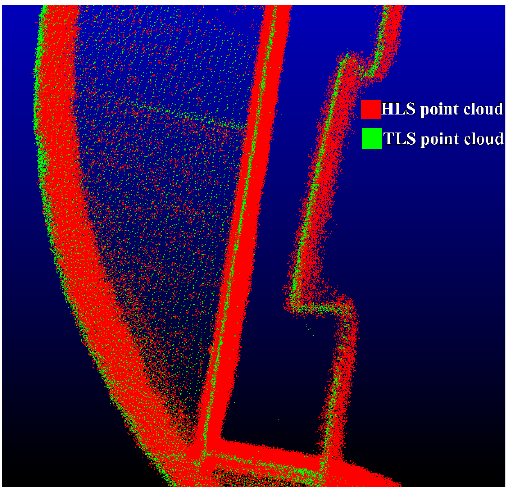
Figure 10. Cross-sectional view of HLS and TLS point cloud data.